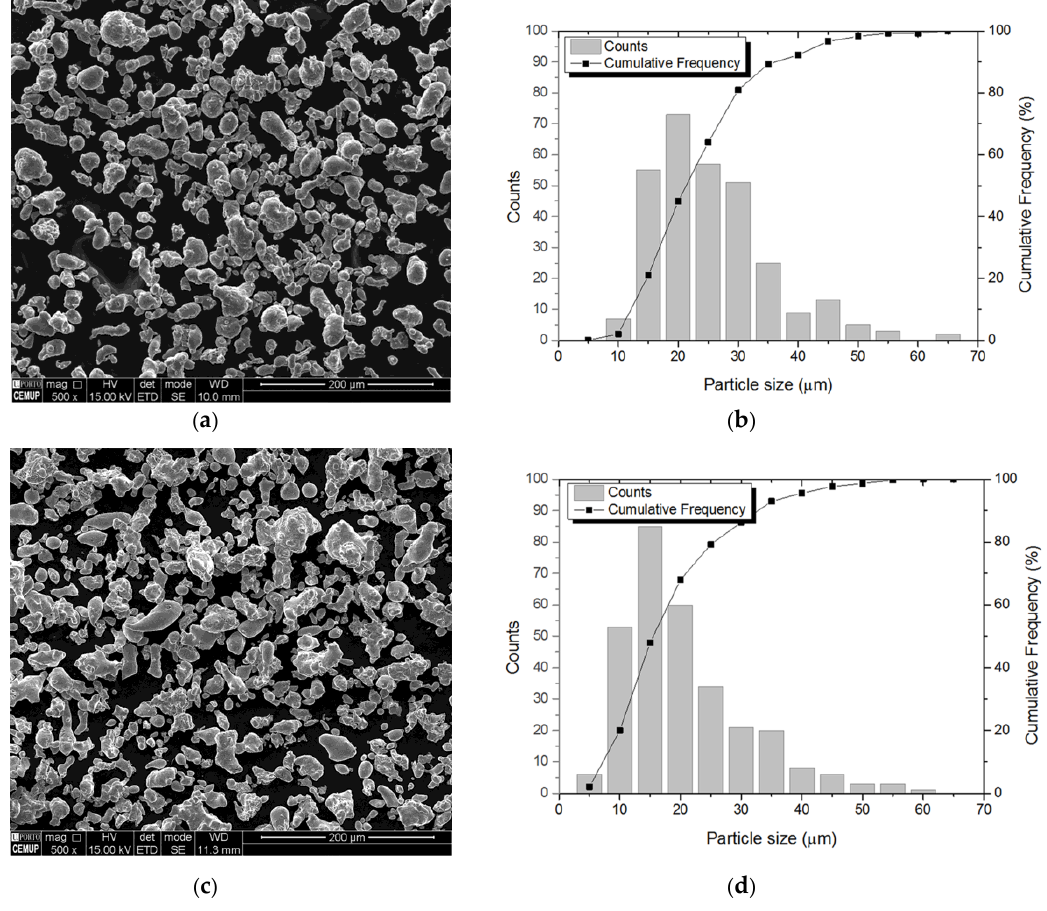
Figure 2. SEM images and particle size distributions of: ( a ) and ( b ) aluminum and ( c ) and ( d ) nickel powders.